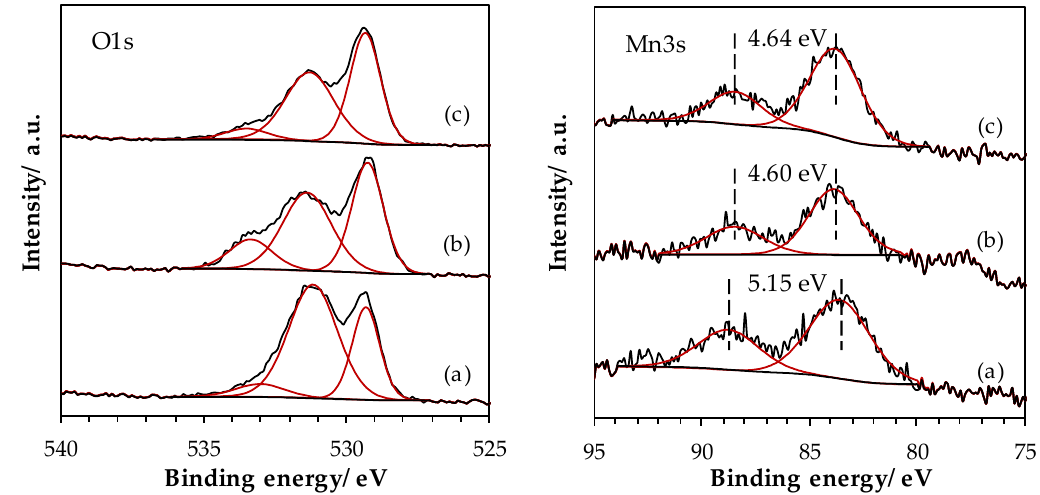
Figure 5. High-resolution spectra of O 1s and Mn 3s core level spectra for LaMnO 3.15 samples: (a) SSR, solid state reaction; (b) HEBM, high-energy ball milling; (c) LEBM, low-energy ball milling.